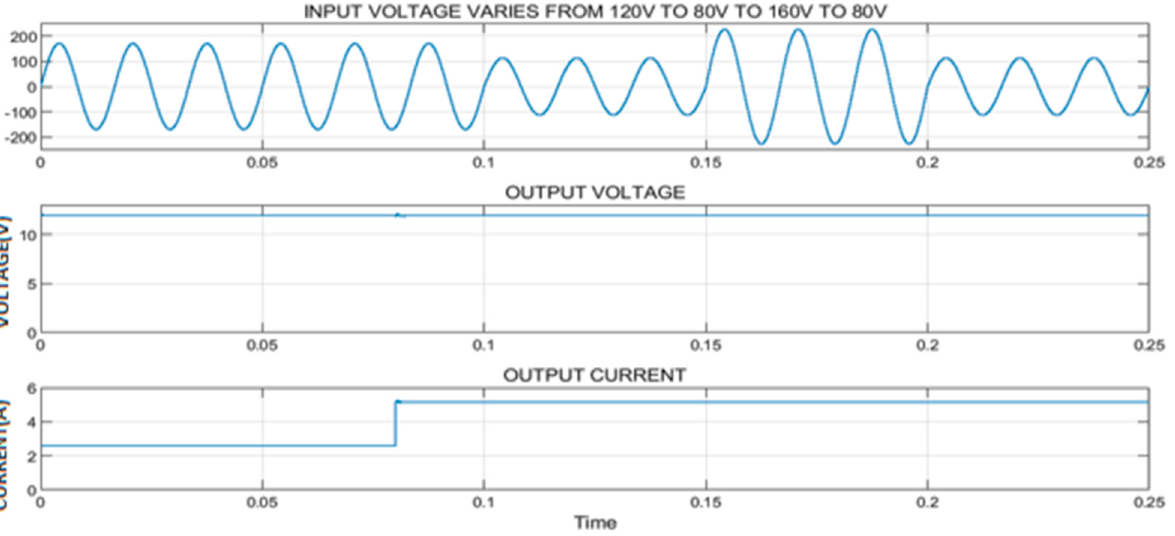
Figure 22. Neuro-fuzzy simulation design.